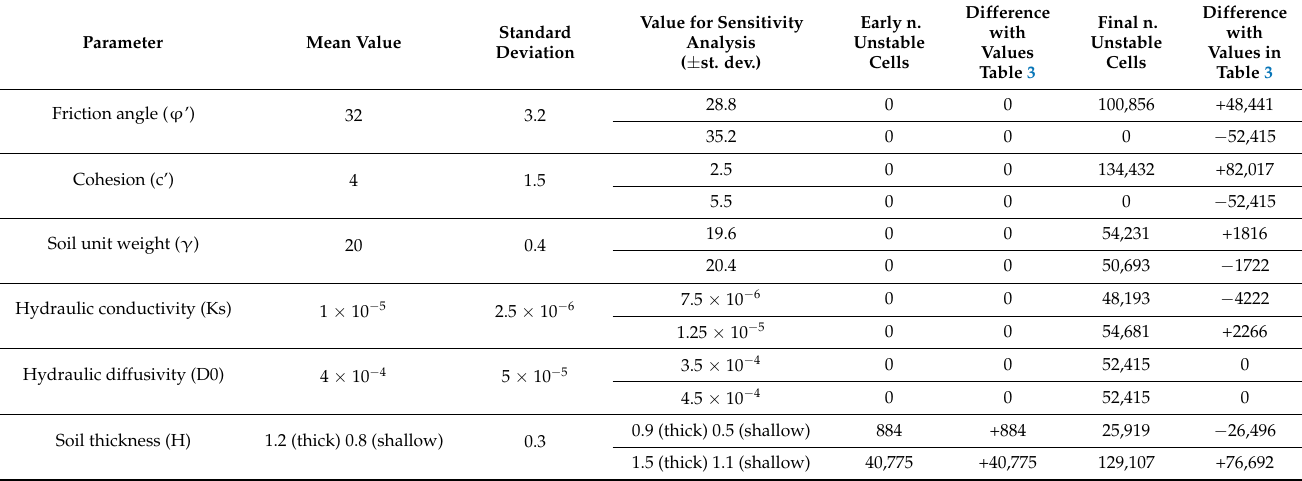
Table 6. Outcome of the sensitivity analysis performed on several input parameters of the TRIGRS model, considering the 2013 landslide